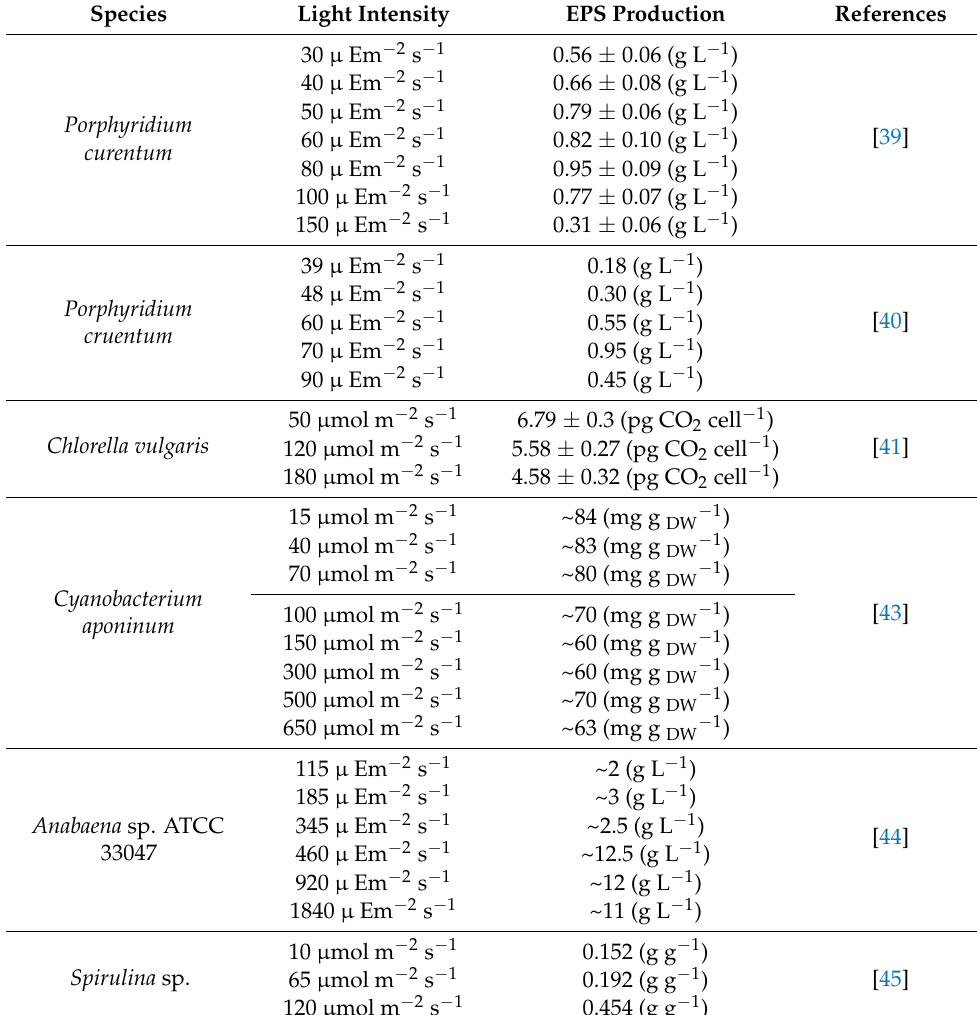
Table 2. Effect of light intensity on EPS